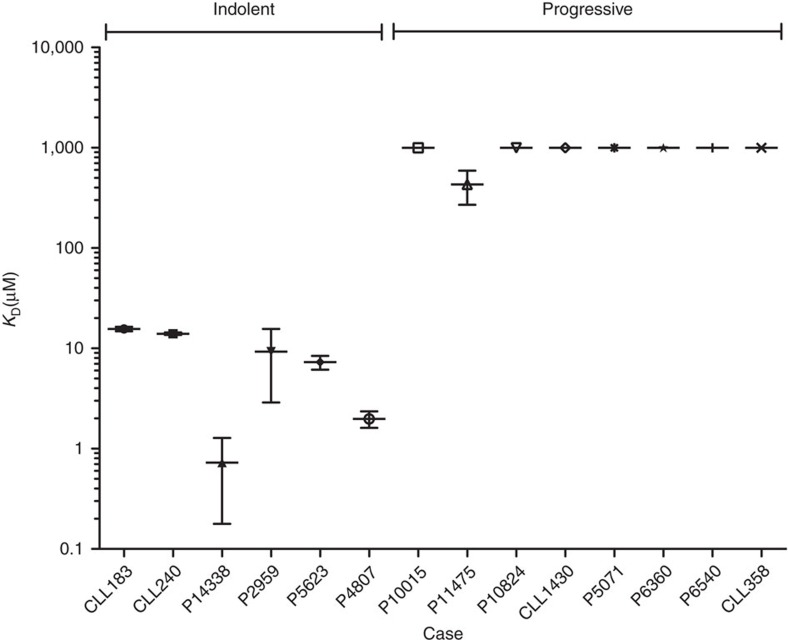
High-affinity homotypic interactions are characteristic of BcRs from indolent CLL cases.The dissociation constants of Fab fragments of BcRs derived from CLL cases were measured using SV-AUC and dilution ITC. Fab fragments from five indolent cases displayed KD values in the 0.7–16 μM range. Among the eight aggressive cases, the KD value for P11475 was 430±160 μM (see Fig. 5), while the remaining Fabs did not show dimeric species at protein concentration up to 20 μM in SV-AUC experiments (plotted at 1,000 μM for visualization purposes). Under the experimental conditions used, the appearance of a dimer peak in the c(S) distribution derived from SV-AUC experiments required at least koff<10−2 s−1 and KD<500 μM (based on simulations with SEDFIT and SEDPHAT). Data are means of three experiments, error bars are standard deviations.